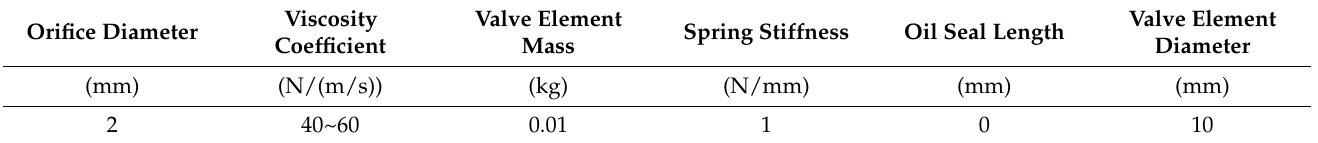
Table 2. Simulation parameters—group